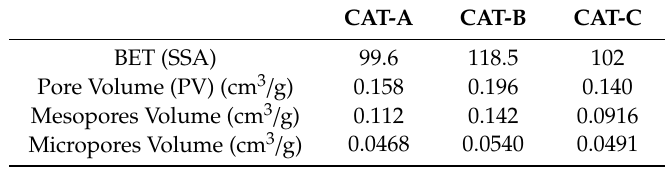
Table 4. Specific surface areas and pore volumes of the free of coke catalysts.